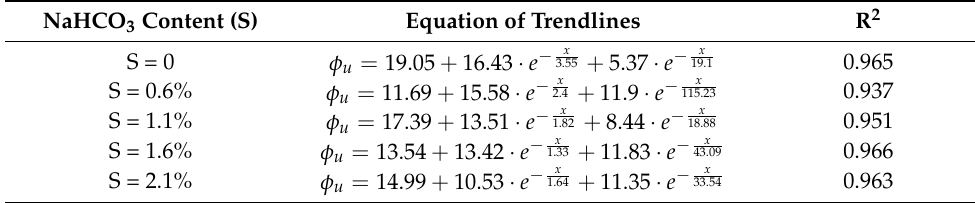
Table 8. Equation of trendlines of inter friction angle versus FTCs at different salt